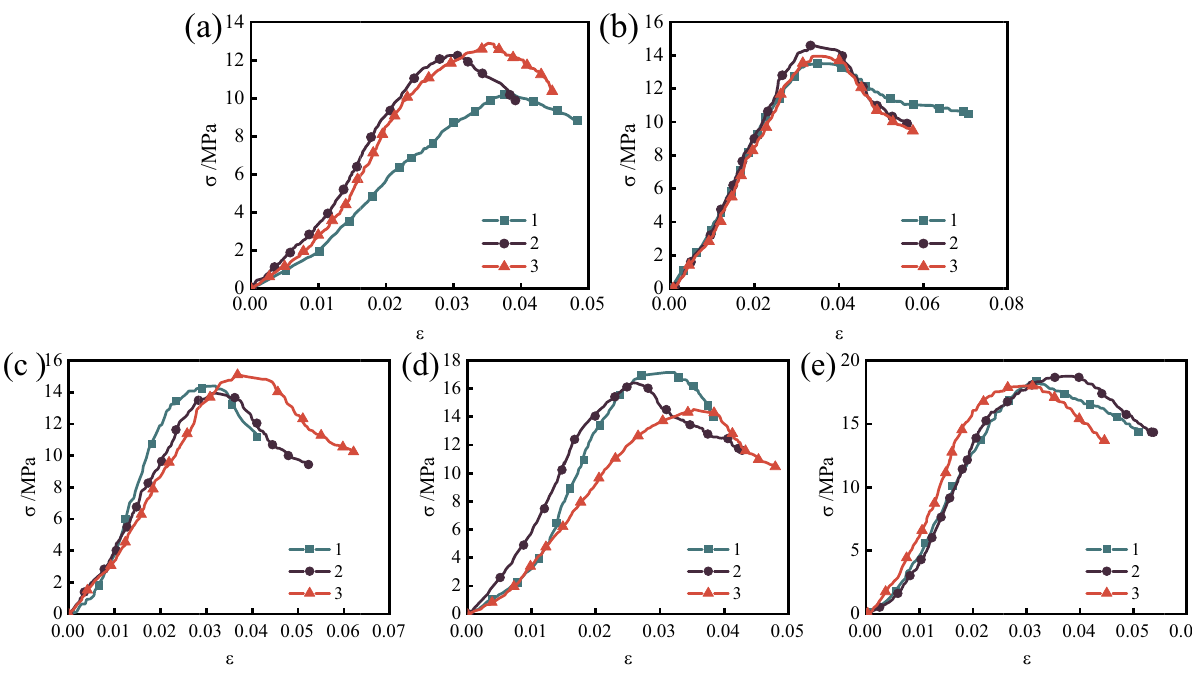
Figure 8: Stress – strain curve of test block: ( a ) yellow mud, ( b ) 0.5% straw, ( c ) 5% starch, ( d ) 5% cement, ( e ) 7% epoxy resin.